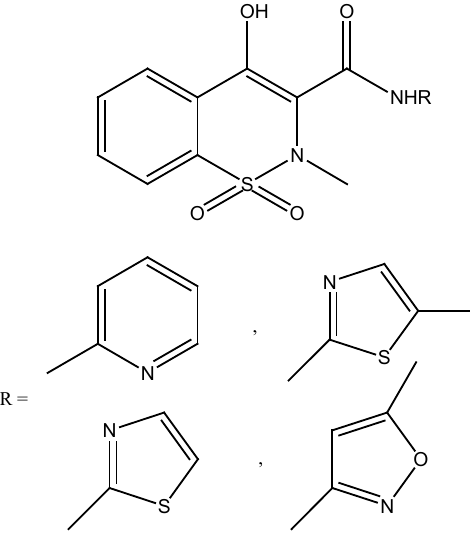
Figure 1. Some Examples for Oxicams.